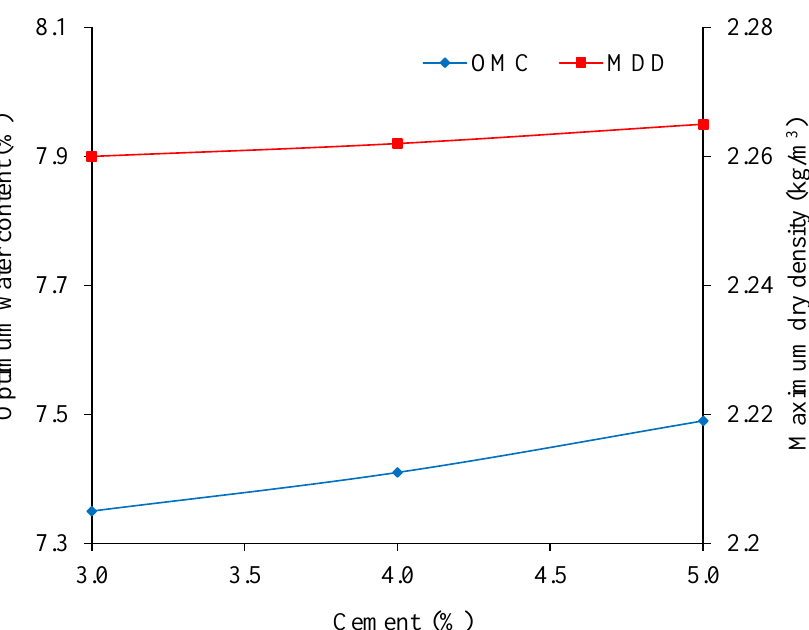
Figure 15. The influence of the cement content on the compaction results.